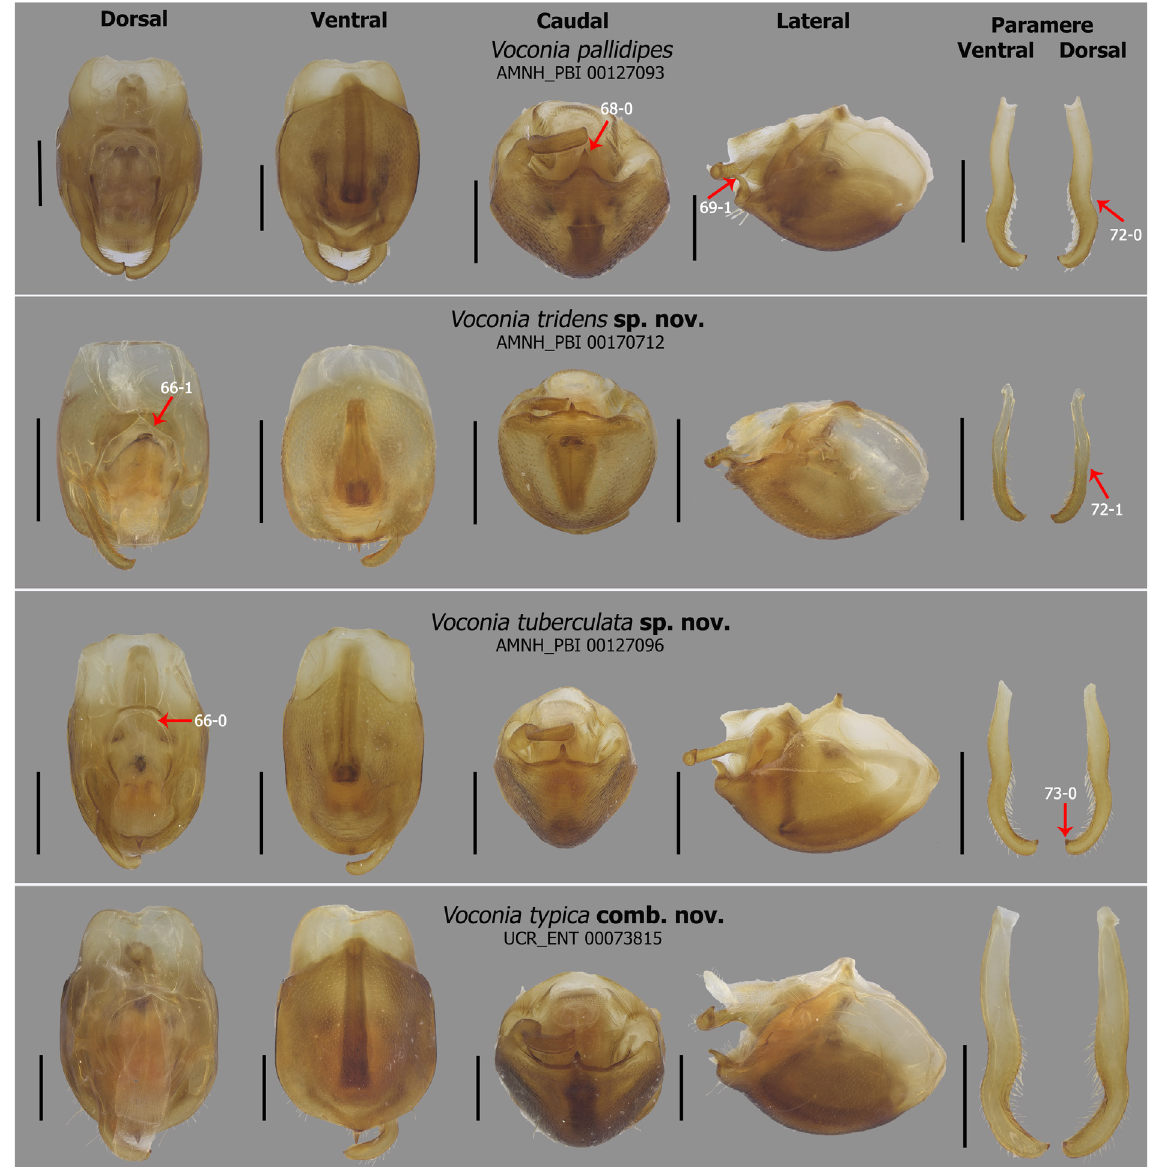
Fig. 13. Pygophore of species of Voconia Stål, 1866. Scale bars = 0.5